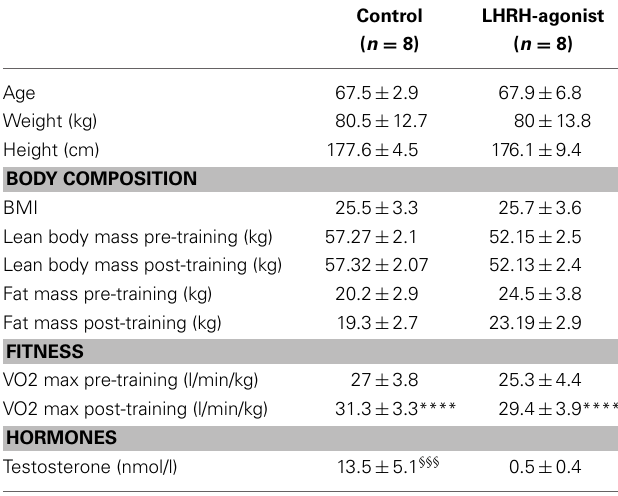
Table 2 | In vivo study